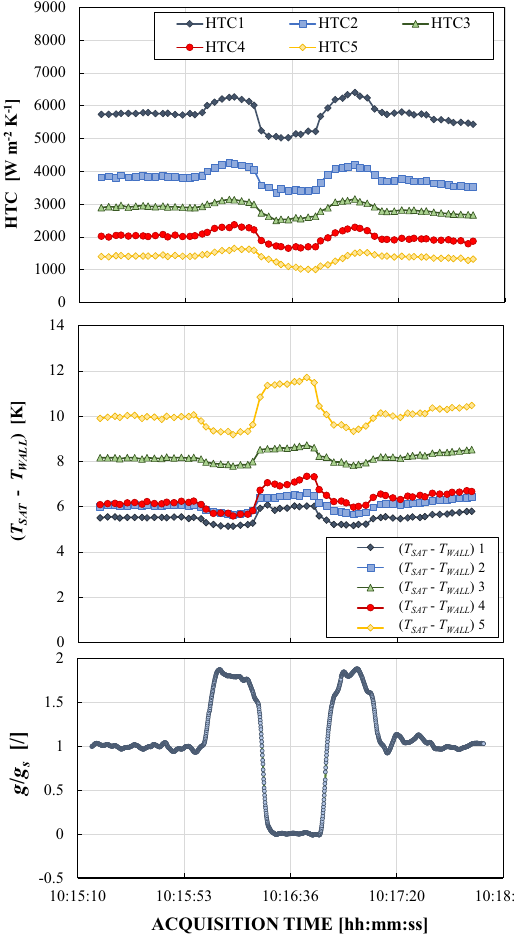
Fig. 1 In-tube condensation heat transfer coef fi cient with the varying gravity level. Temporal variation of gravity acceleration, saturation-to-wall temperature difference and heat transfer coef fi - cient of HFE-7000 during one parabola inside a 3.38 mm inner diameter channel at 130 kg m − 2 s − 1 (Azzolin et al. 27 saturation-to-wall temperature difference and heat transfer coef fi - cient in the fi ve heat transfer sub-sectors for heat transfer measurements (numbering from 1 to 5 refers to decreasing vapor quality values) at G = 130 kg m − 2 s − 1 . During microgravity, the saturation-to-wall temperature differences increase leading to smaller heat transfer coef fi cient values. The difference between the heat transfer coef fi cient measured in microgravity conditions and in normal gravity was found to be negligible at high mass fl ux ( G = 170 kg m − 2 s − 1 ), while reaching 20% at small mass fl ux ( G = 70 kg m − 2 s − 1 ). Similar conclusions were drawn in the works by Lee et al. 1,2 , where local heat transfer coef fi cients and fl ow pattern visualizations of FC-72 obtained inside a 7.1 mm inner diameter channel during a parabolic fl ight campaign are reported. Tests were performed under microgravity, Lunar (0.17 g s ) and Martian gravity (0.377 g s ) at mass fl ux from 129 to 341 kg m − 2 s − 1 and at 60 – 63.4 °C saturation temperature. The in fl uence of gravity on fl ow pattern and condensation heat transfer was signi fi cant at low FC-72 mass fl uxes. Lunar and Martian gravity caused the fi lm to become thicker at the bottom of the tube and thinner at the top, leading to enhanced condensation heat transfer rates compared to microgravity conditions. With the aim to widen the experimental database of Azzolin et al. 27 , Berto et al. 28 employed the same test section to perform T